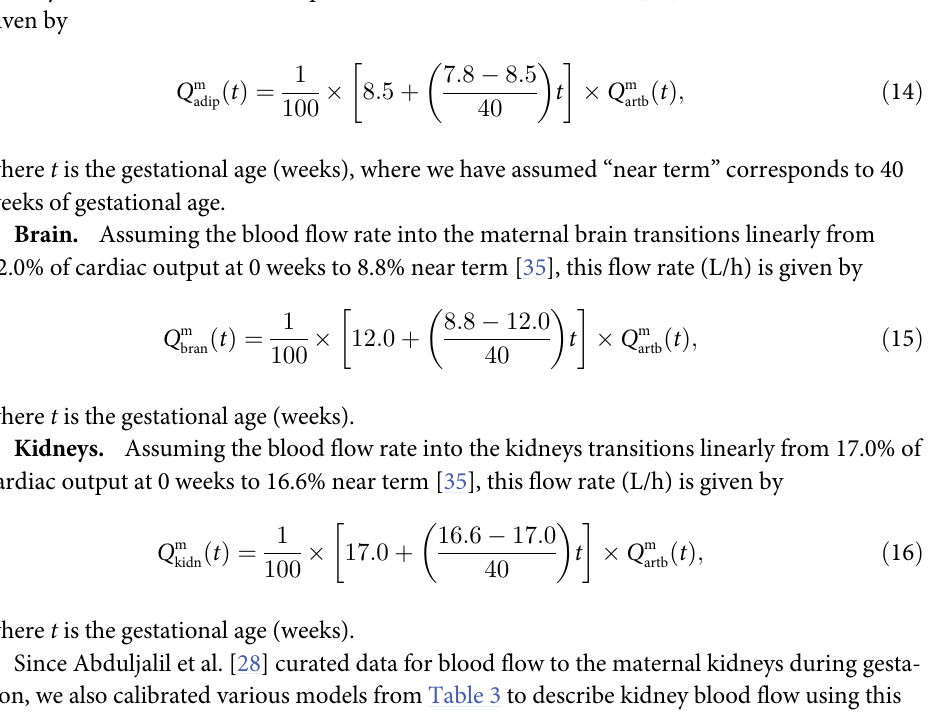
Table 14 shows the maximum likelihood estimates of the parameter values for all models con- sidered along with the associated log-likelihood and AIC values. Fig 9 shows the cubic model of Eq 13 along with several other models for maternal cardiac output. Adipose tissue. Assuming the blood flow rate into the maternal adipose tissue transitions linearly from 8.5% of cardiac output at 0 weeks to 7.8% near term [35], this flow rate (L/h) is given by